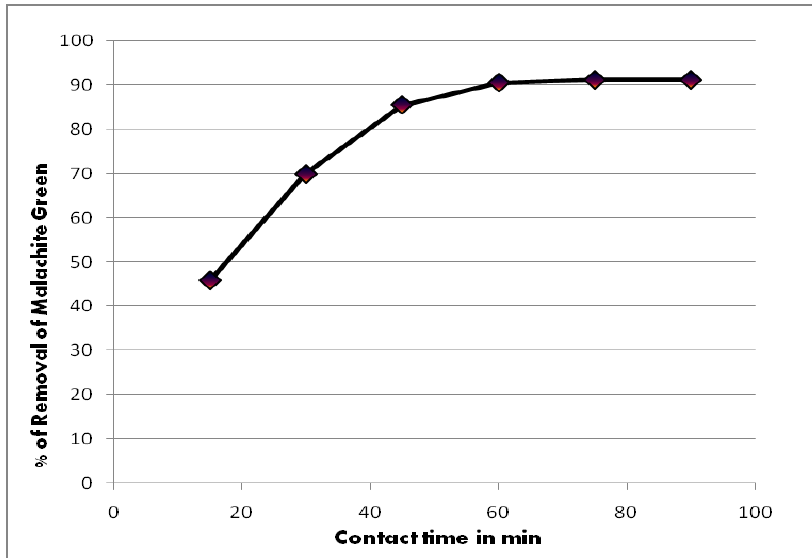
Figure 4. Effect of Contact time on the adsorption of Malachite green onto TPC [MG]= 100mg/L: Adsorbent dose = 25mg/ 50ml: